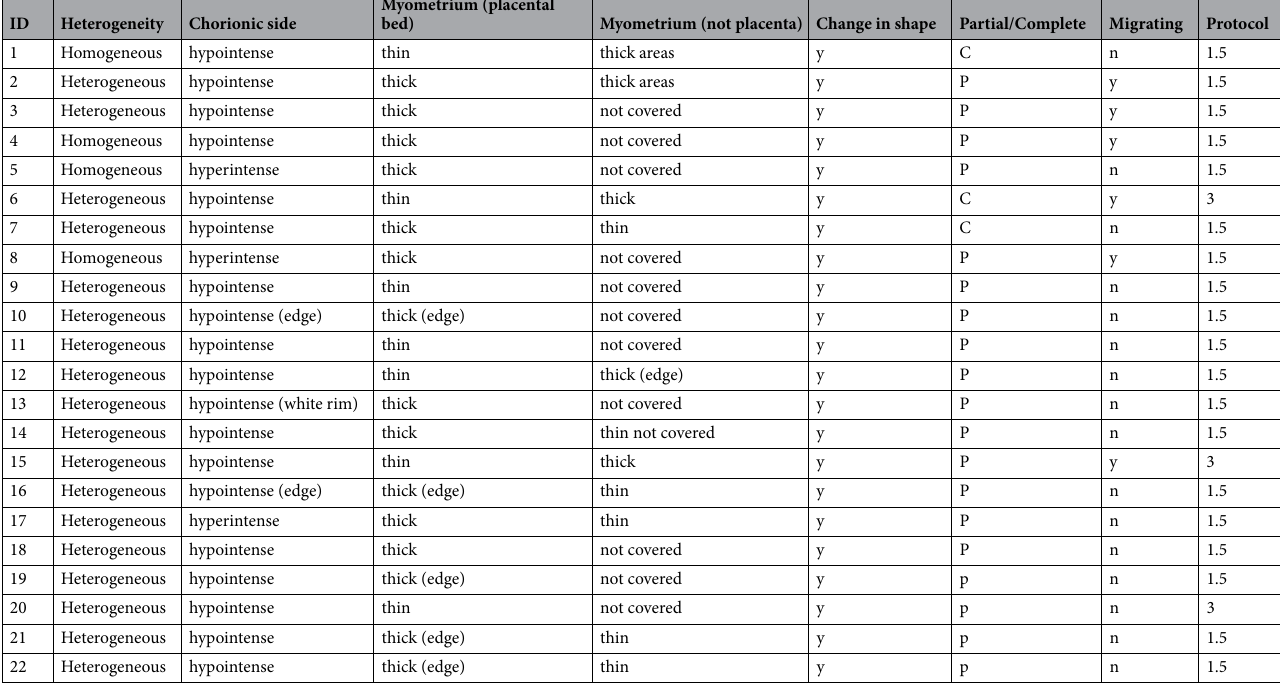
Table 2. Overview over the considered cases of contractile activity and observations on the T2* maps. Heterogeneity refers to the overall signal intensity within the placenta, where “heterogeneous” refers to a visible clear observable change such as marked with a blue arrow in Fig. 2 b and c. and homogenous showed no focal placental signal intensity changes. Chorionic side assesses the observable change on the chorionic side of the placenta, most notably whether a dark rim was observed (“hypointense”) (Fig. 2c). The myometrial thickness is observed both underneath the placenta and at a distance. Any changes in shape are recorded. ‘Partial’ or ‘complete’ describes whether the changes are observed in the entire placenta or only in a part of it. Migrating captures whether the thickening observed changed location during the dynamic scan. In the final column, the scanner field strength and protocol is indicated, with 1.5 and 3 representing in turns the 1.5 T and 3 T scanner.